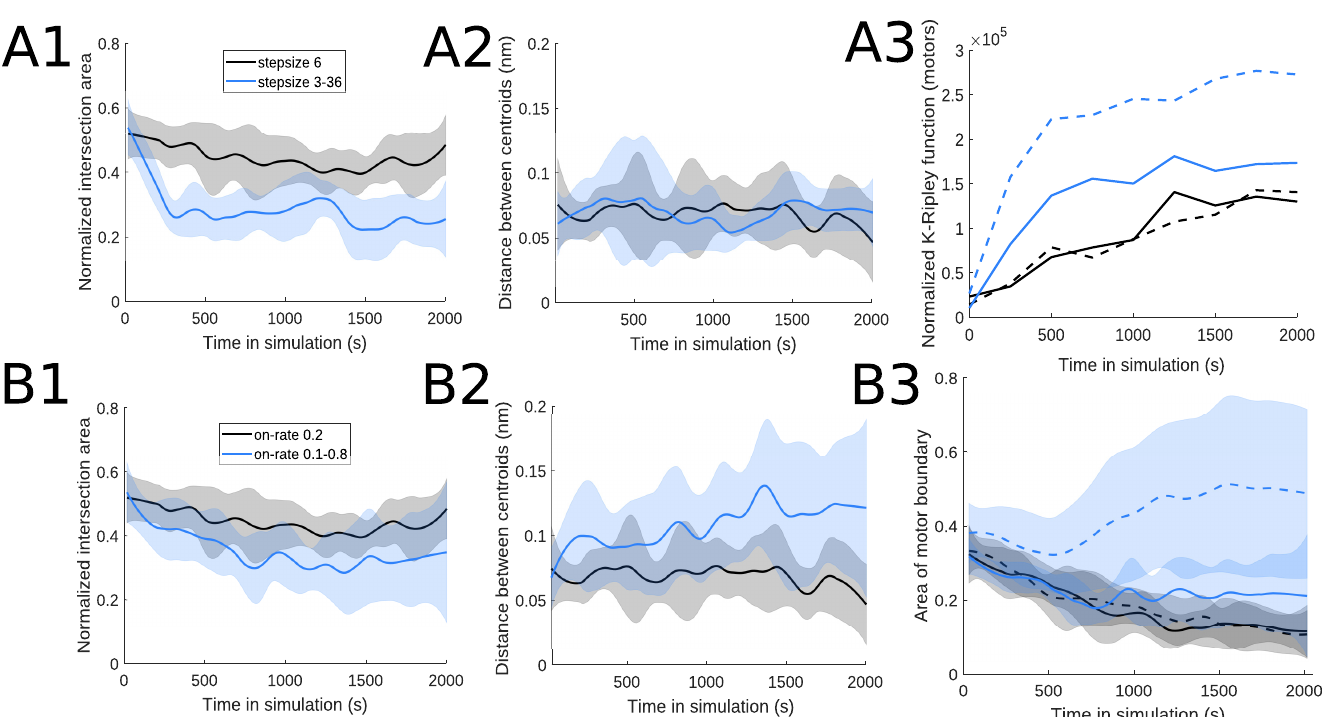
Fig 10. Two motor populations with (A) different step sizes or (B) different binding rates self-organize into spatially distinct domain. (A1) and (B1) shows decreasing intersection area of the two motor protein populations (blue line) compared to two identical motor populations with baseline parameters (black line; Fig 3). (A2) and (B2) show displacement of the centroid of the polygon bounding the motor proteins, further suggesting spatial segregation. (A3) The normalized K-Ripley function, which measures the spatial distribution of each motor protein population (§ 5.7), and (B3) the area of one of the motor population’s boundary both increase over time, suggesting the actin filaments become more clustered; the first motor population is indicated with blue solid lines (3 nm step size in A, and 0.1/s on-rate in B), and the second motor population with dashed blue lines (36 nm step size in A, and 0.8/s on-rate in B). The black curves correspond to simulations with two motor populations with identical baseline parameters. Unless otherwise indicated above, the parameter values used for both motors are d step = 6 nm, k head,bind = 0.2/s, F s = 100 pN, range heads = 15–30 (see Table 1). Solid and dashed lines indicate the average and shaded areas indicate the standard deviation over 10 independent stochastic runs.